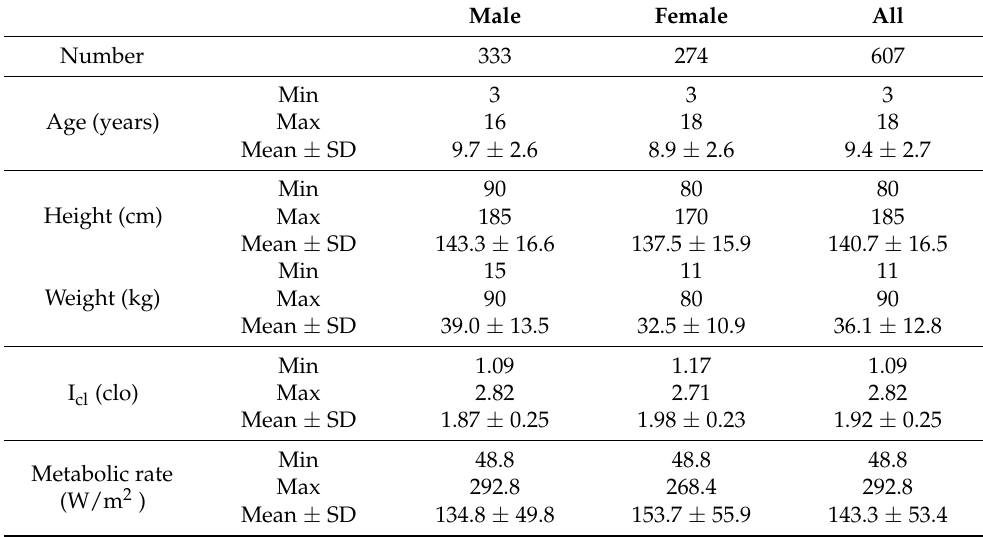
Table 3. Characteristics of survey